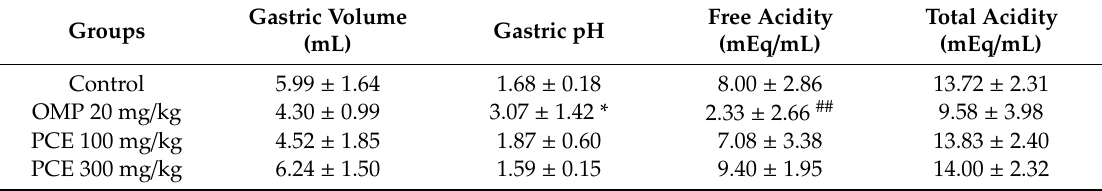
Table 1. E ff ects of PCE on gastric secretion parameters in pylorus-ligated Table 1. Effects of PCE on gastric secretion parameters in pylorus-ligated rats. Groups